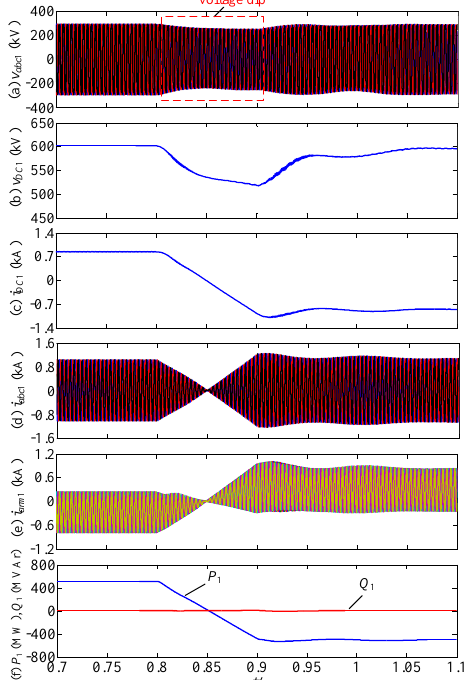
Figure 5. Power reversal waveforms of MMC 1 in the DC/DC converter: ( a ) three-phase voltages; ( b ) DC voltage; ( c ) DC current; ( d ) three-phase currents; ( e ) arm currents; and ( f ) active and reactive powers.